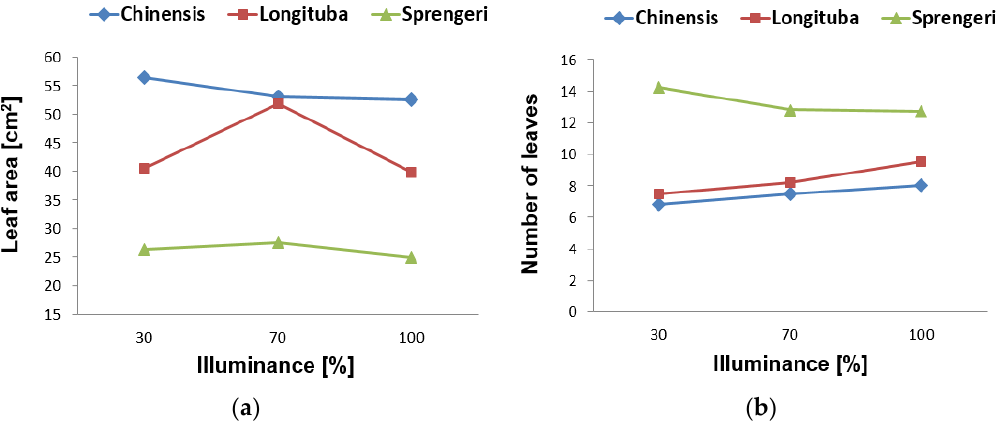
Figure 2. Comparison of plant growth according to illuminance, (a) Leaf area; (b) Number of leaves [17].